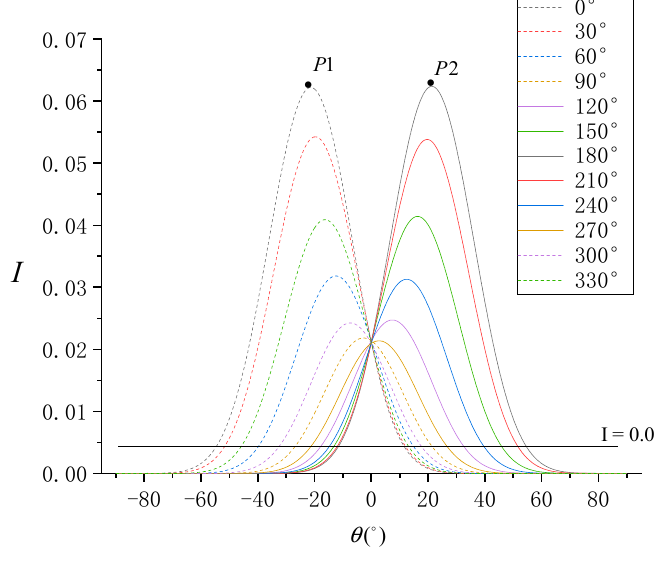
Figure 9. Normalized SG radiance ( I ) simulated by each SVA ( θ ) under different sun azimuths.